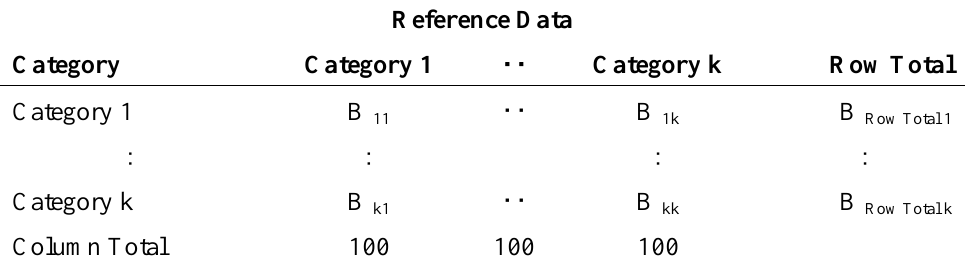
Table 2. Error matrix for classification map B.